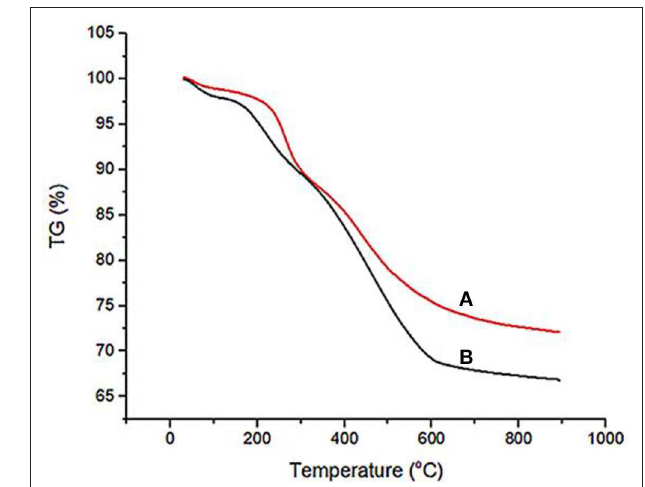
FIGURE 7 | TG analysis of Fe 3 O 4 @OS (A) and Fe 3 O 4 @OS-SO 3 H (B)